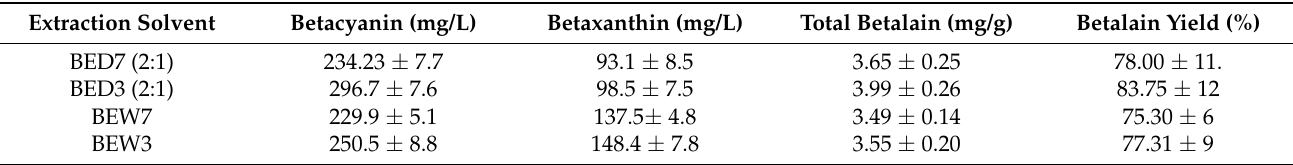
Table 2. Betalain content on fresh weight and betalain yield (%) in beetroot DES (2:1) (BED7 and BED3) and water extracts (BW7 and BEW3).